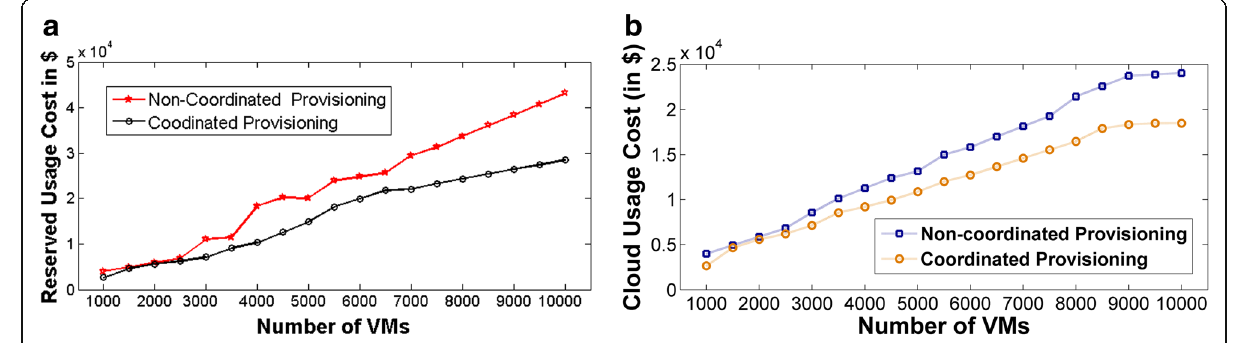
Fig. 4 a Reserved Usage Cost for Cloud Users in CCM. b On-demand Usage Cost for Cloud Users in CCM